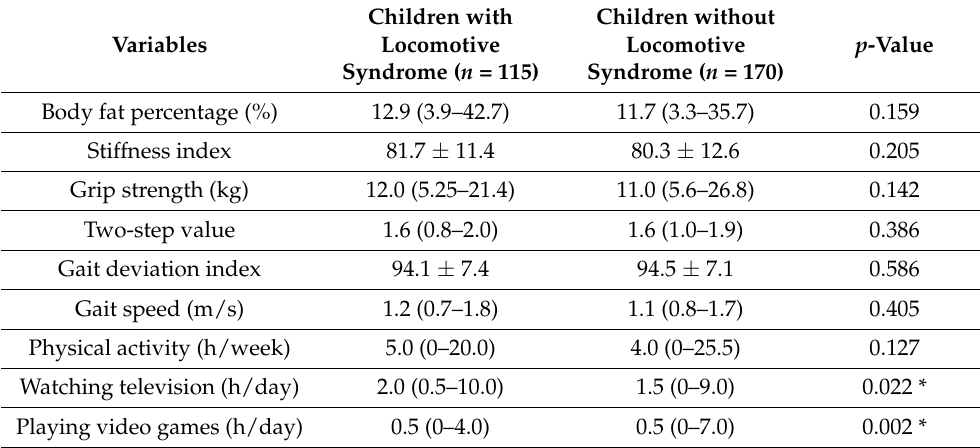
Table 2. Physical function outcomes and questionnaire.